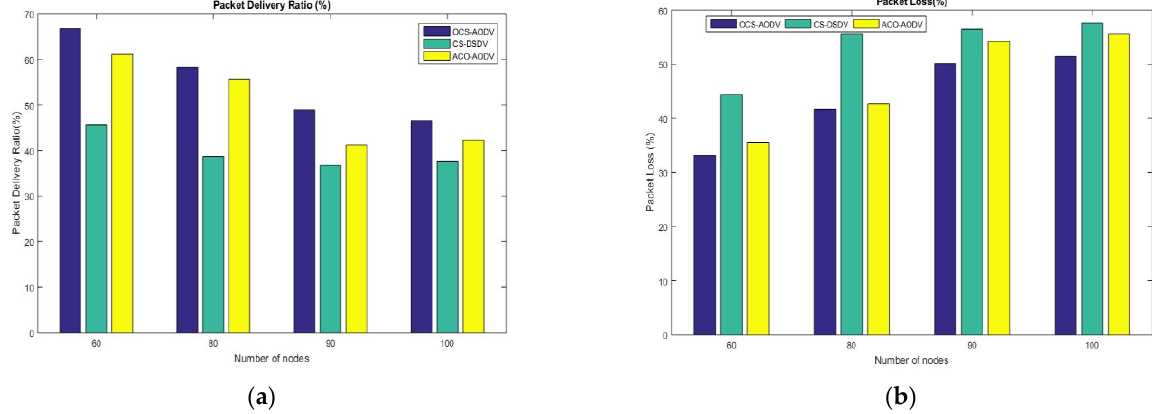
Figure 7. The performance of the three schemes in terms of packet-delivery ratio and packet-loss metrics. ( a ) Depicts the PDR of the three routing protocols ( b ) Depicts the dropped packets results of the three protocols.